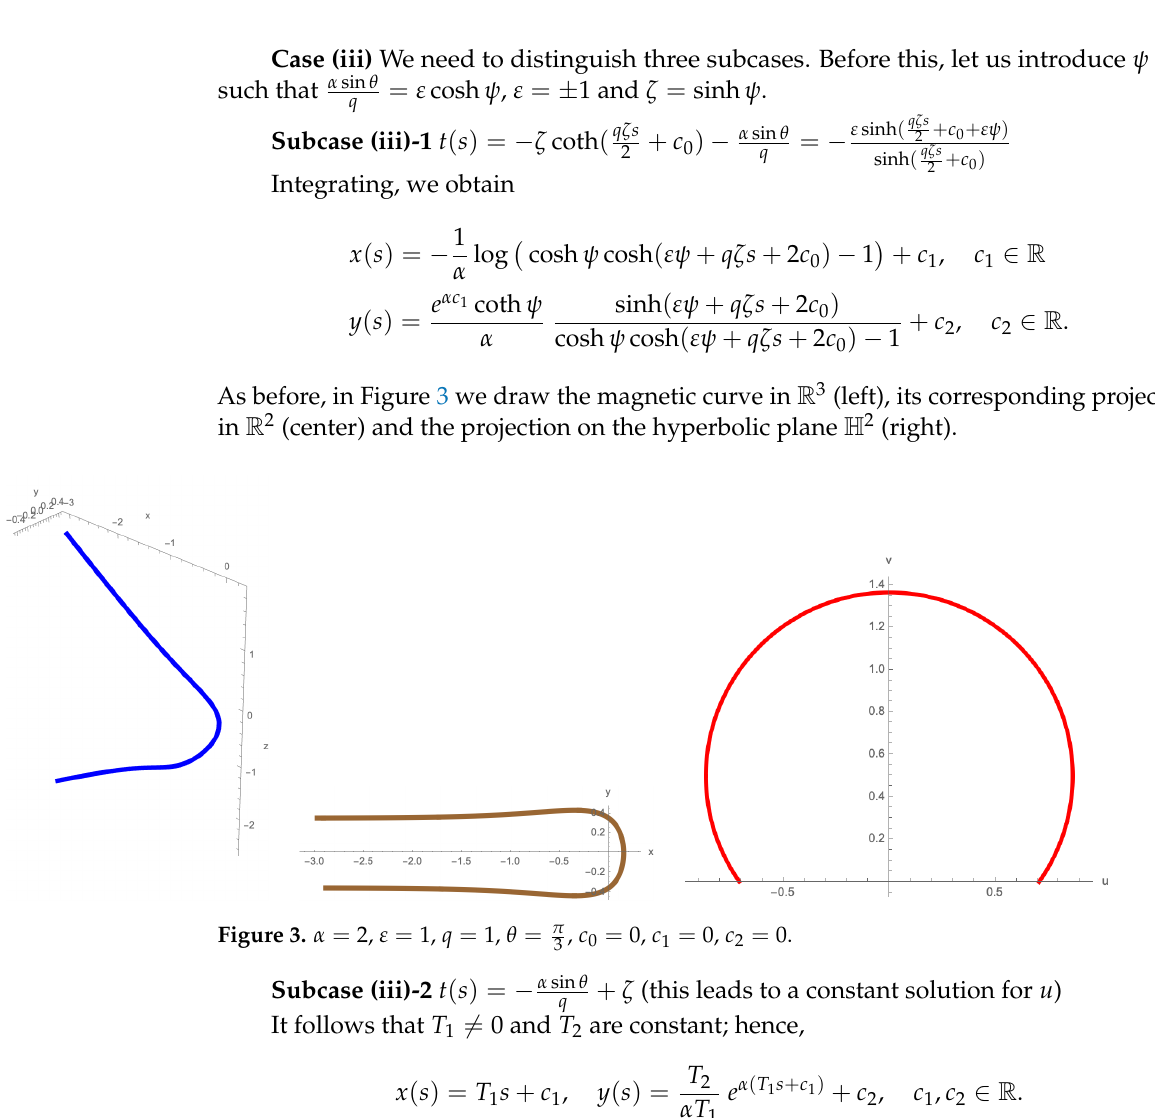
Figure 3. α = 2, ε = 1, q = 1, θ = π